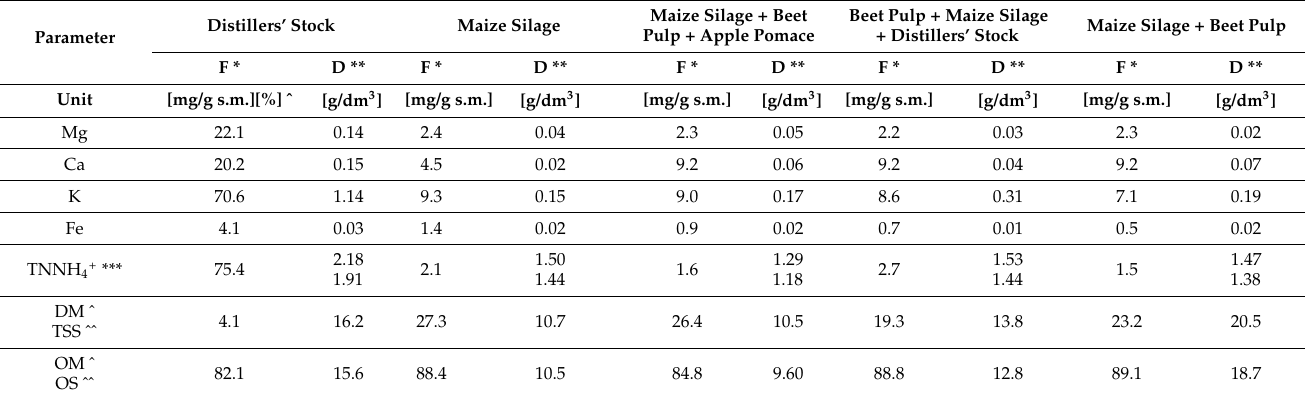
Table 15. Average values for individual parameters characterizing the feedstock and the resulting digest (own elaboration based on